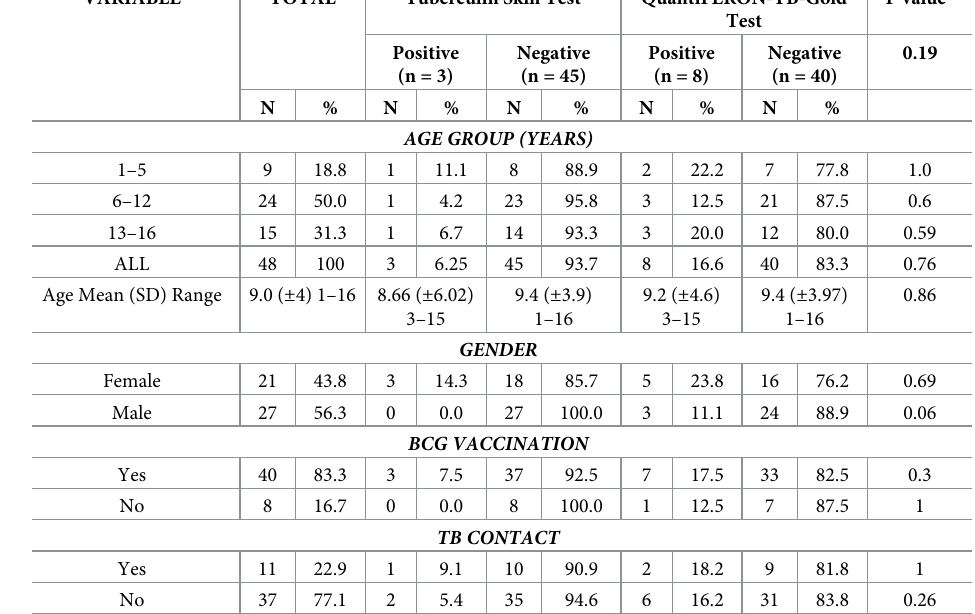
Table 1. Results of TST and QFT test in the diagnosis of LTBI, according to age, gender, BCG vaccination and TB-contact. VARIABLE